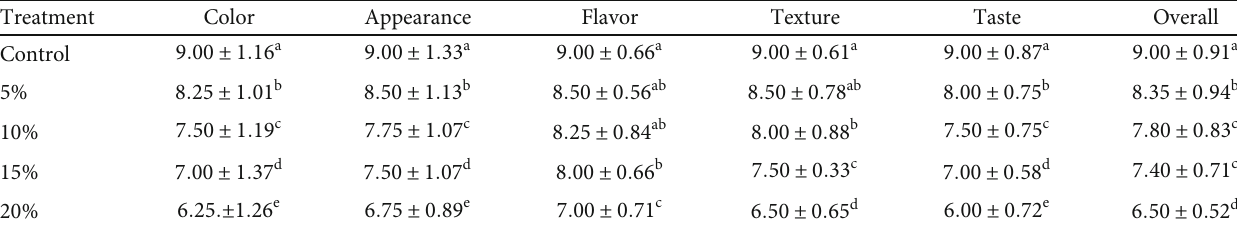
Table 4: Sensory evaluation of biscuits.